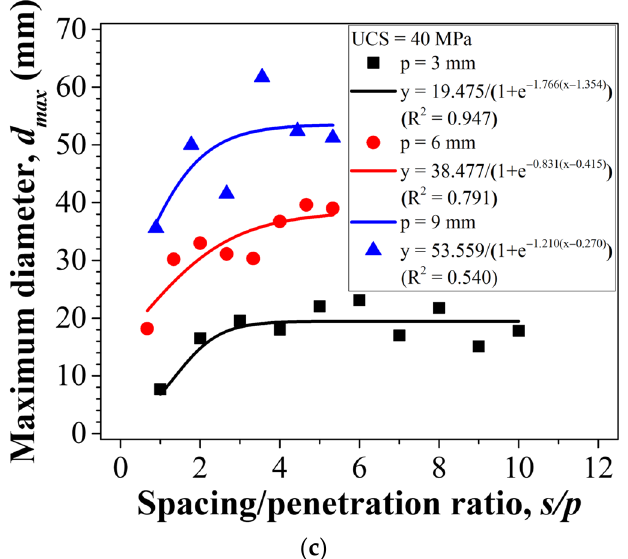
Figure 10. Relationship between maximum diameter and s / p ratio: ( a ) rock of UCS 20 MPa; ( b ) rock of UCS 30 MPa; ( c ) rock of UCS 40 MPa.